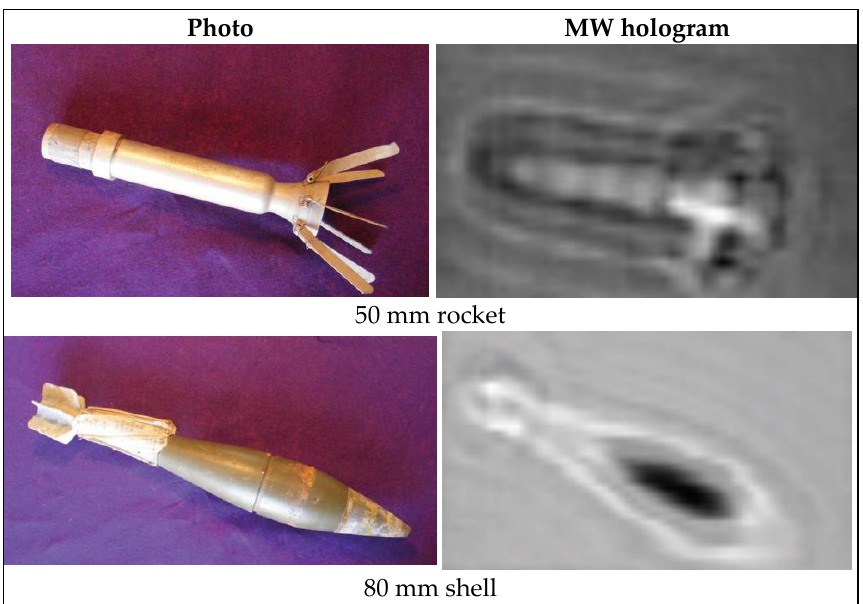
Figure 17. HSR images recorded by RASCAN-4/4000.